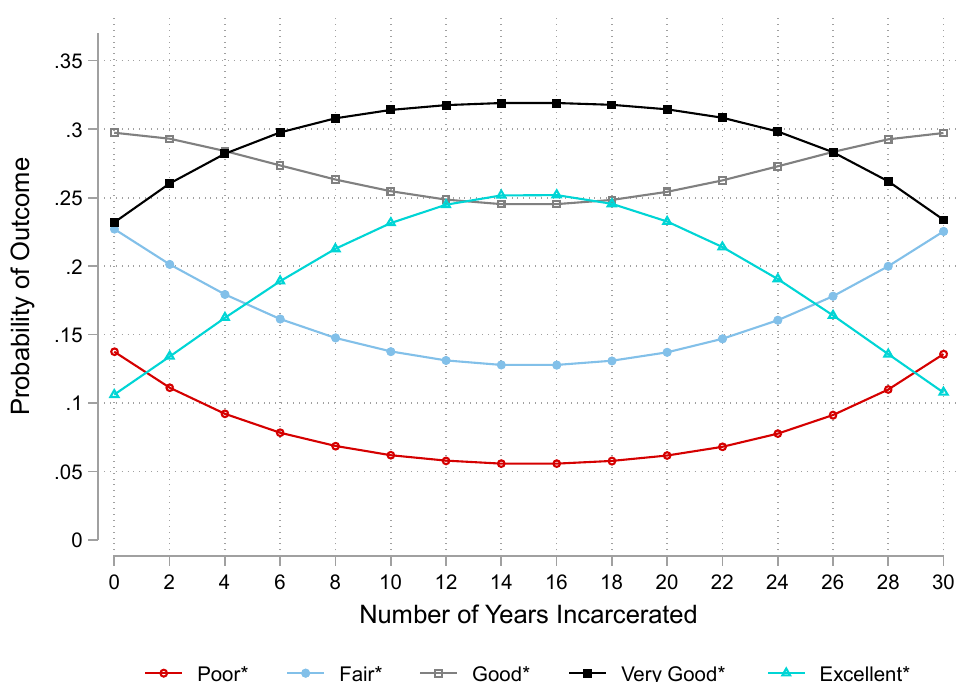
Figure 3. Predictions of Oral Health by Number of Years Incarcerated among Formerly Incarcerated African American Men in the National Survey of American Life, 2003. Note : Fully-adjusted estimates generated from Model 4 in Table 2 (n = 252). * Probabilities of an outcome across years incarcerated are significantly different for zero at p < 0.05 indicating curvilinear associations.